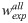
Robustness of the balanced detection for dipolar architectures γ
α.Top: fitted architectures for α = 0.5, 1, 1.5 visually look very different. Bottom: SF tuning corresponding to balanced detection as a function of α, computed with the same procedure as in Fig 5. The gray band corresponds to the SF tuning width on the whole map wexpall and the pink band to our estimate in the vicinity of PCs wexpPC17 (Fig 6). Blue circles and error bars correspond to the mean and standard deviation of the SF FWHH at the tradeoff for different values of the parameter α.